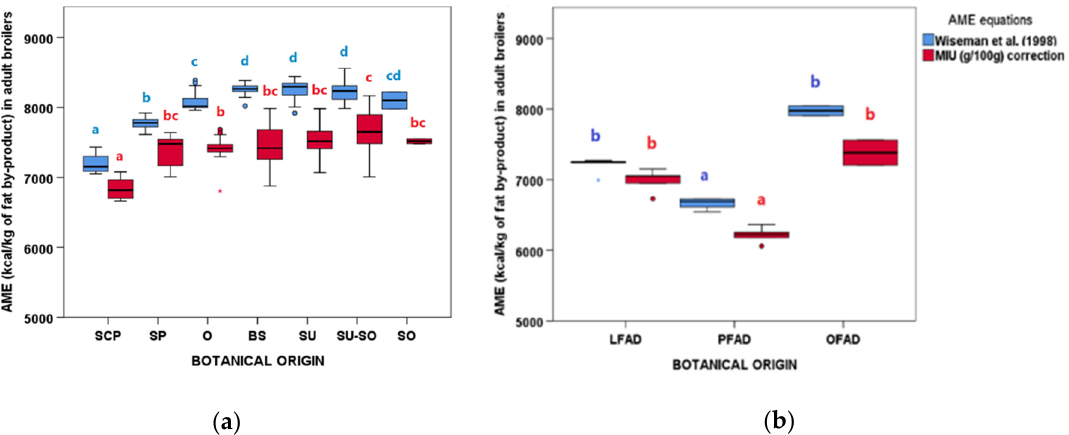
Figure 7. Apparent metabolizable energy (AME) calculated for adult broilers according to Wiseman’s equation [28] and by applying the MIU (g/100 g) correction to it [32] of ( a ) acid oils from chemical refining ( n = 79) and ( b ) fatty acid distillates from physical refining ( n = 13). See Table 1 for botanical group abbreviations. Within each type of refining and variable, botanical groups bearing different letters (a–d) are significantly different according to Kruskal–Wallis test and post-hoc comparisons ( p ≤ 0.05).